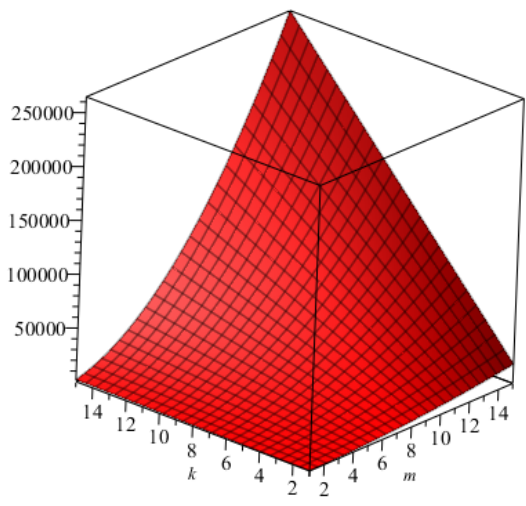
Figure 5. The graphically representation of the second Zagreb eccentricity index M ∗∗